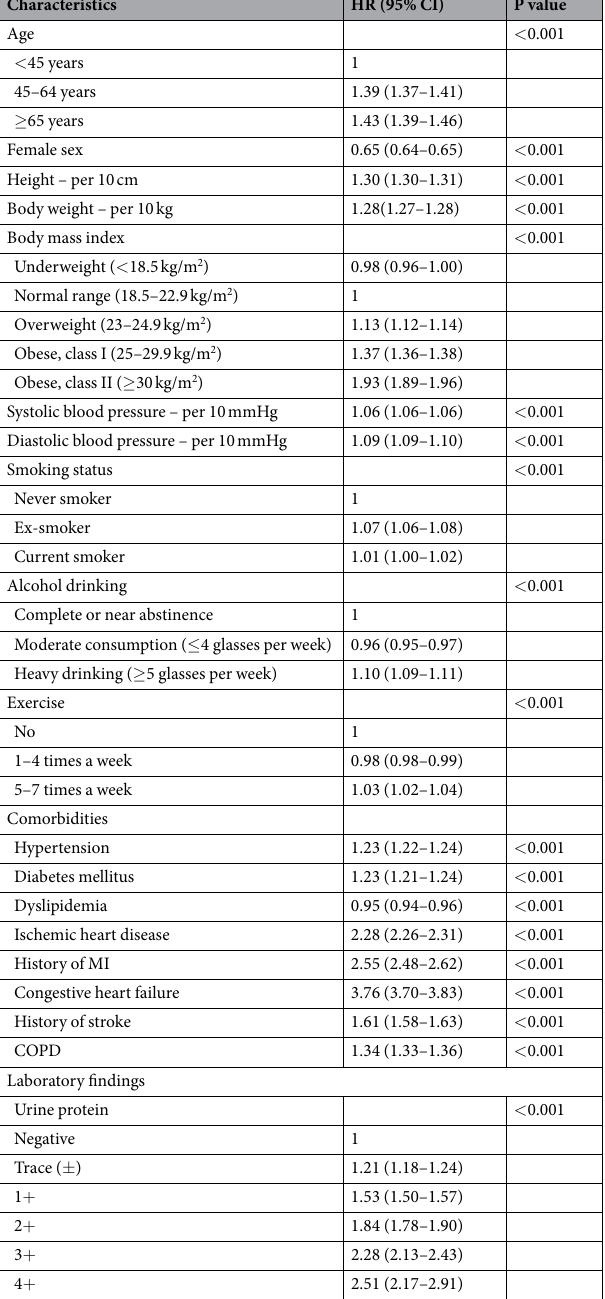
Table 2. Age and sex-adjusted hazard ratios for the risk of atrial fibrillation. COPD, chronic obstructive pulmonary disease; CI, confidence intervals; HR, hazard ratio; MI, myocardial